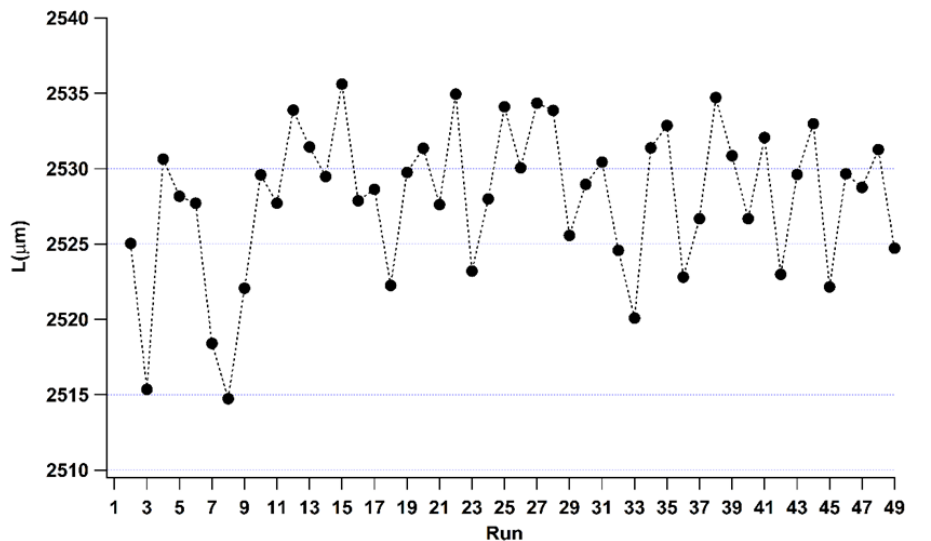
Figure 5. Length values of 48 consecutive molded samples (the first not completed is neglected).